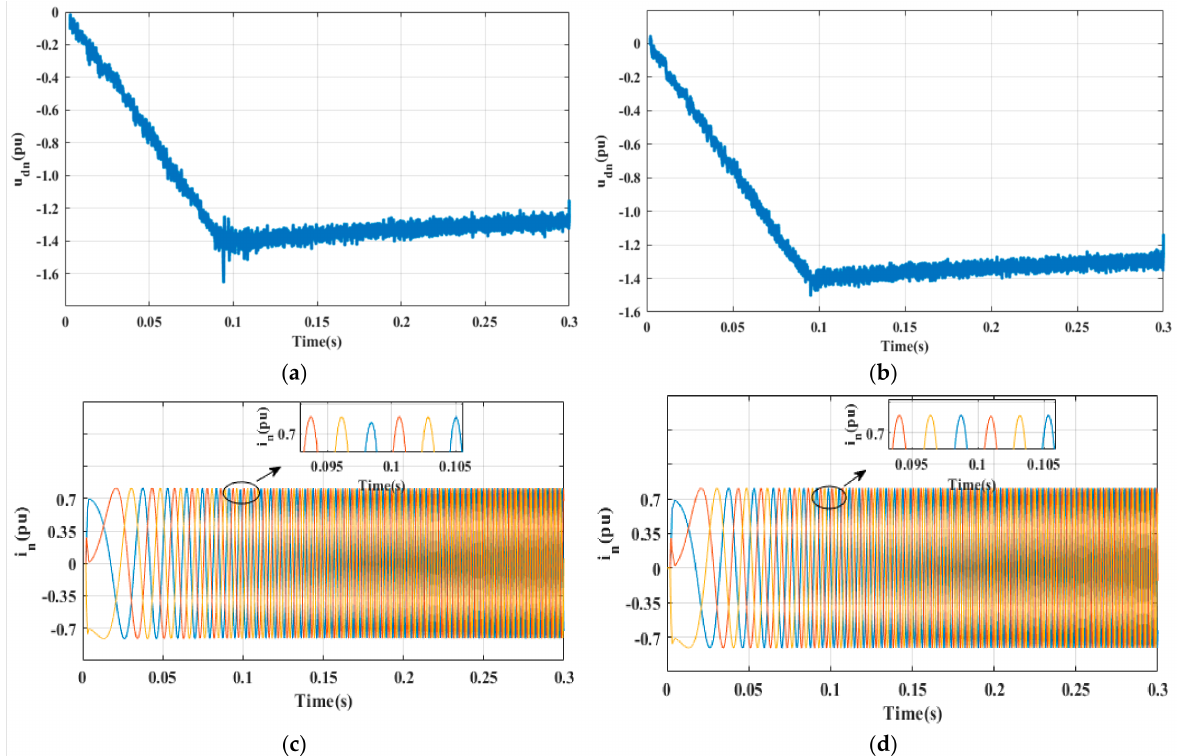
Figure 9. The stator voltage d–axis component and three-phase current waveform before and after the voltage instruction compensation algorithm is added. ( a ) the former stator voltage d–axis component is added. ( b ) the latter stator voltage d–axis component is added. ( c ) the former three–phase current waveform is added. ( d ) the latter three–phase current waveform is added.